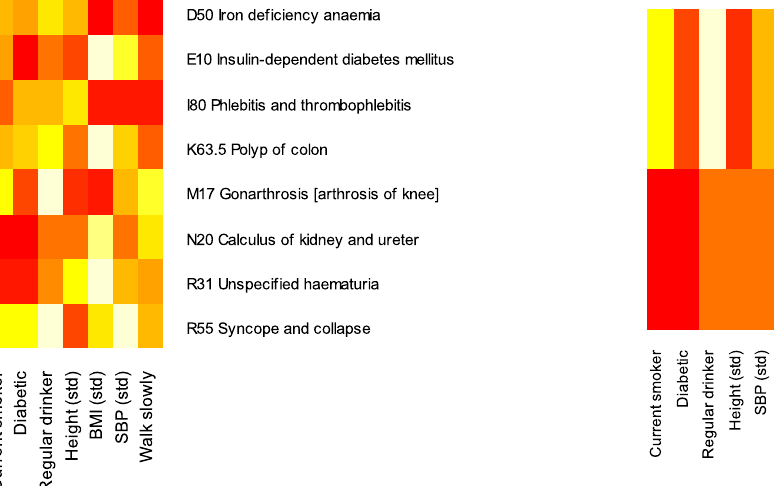
Figure 4. Disease pairs with statistically significant differences in their associations with risk factors at the 0.05 level after an FDR multiple-testing adjustment. With all associations (left), and without BMI (right). Red indicates an association with higher risk for women than men, white a lower risk, and orange neutral. Without BMI as a risk factor, only two diseases continue to have statistically significant differences. The figures were produced with R 34 and the “gplots” 41